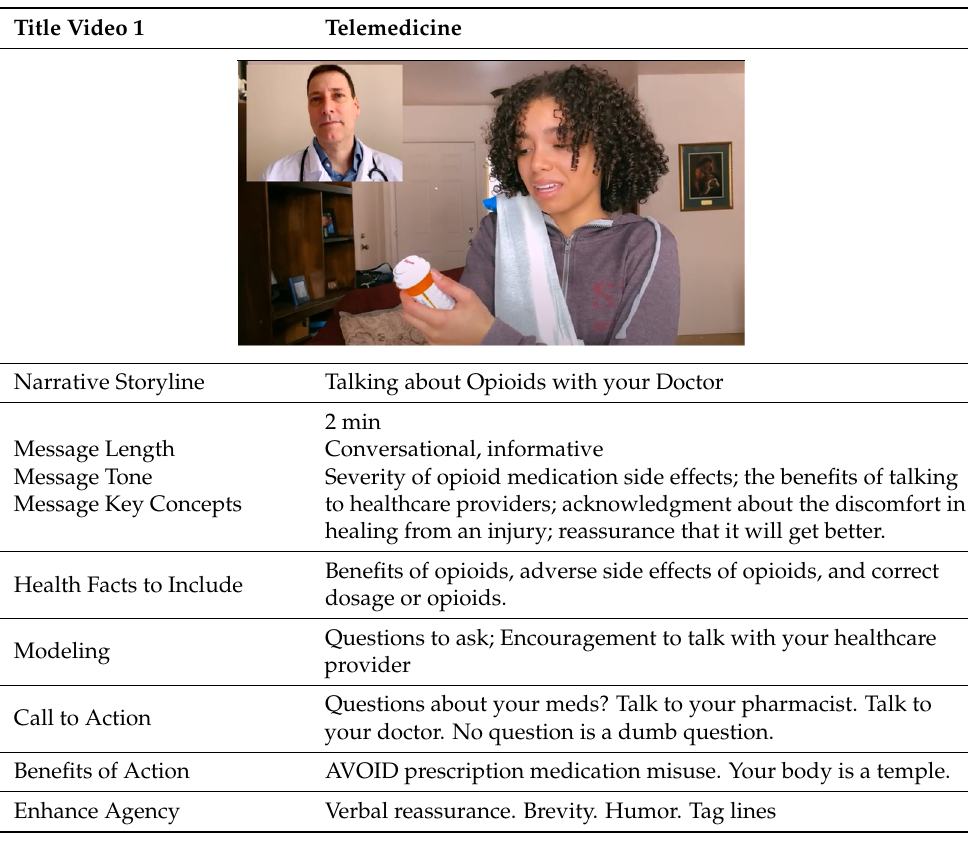
Table 1. “Student Athlete Wellness Portal” Video Intervention Example.